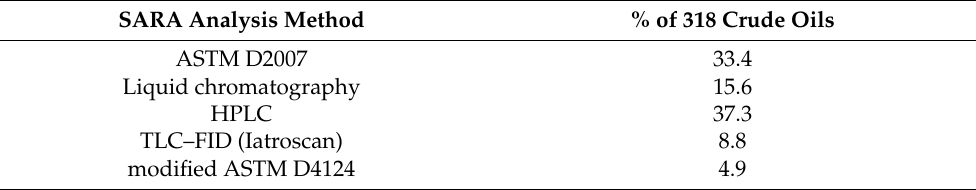
Table 6. Distribution of employed methods to perform SARA analysis of 308 crude